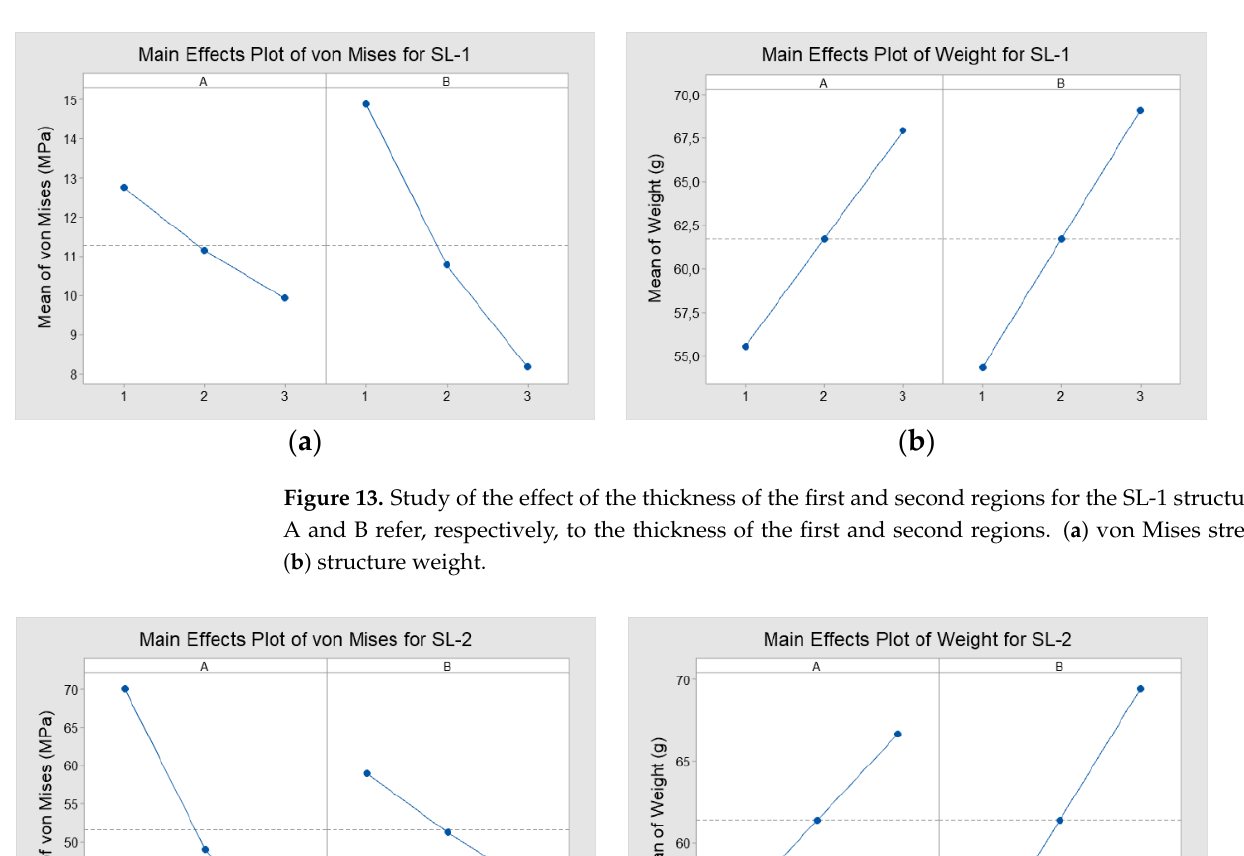
structure weight.